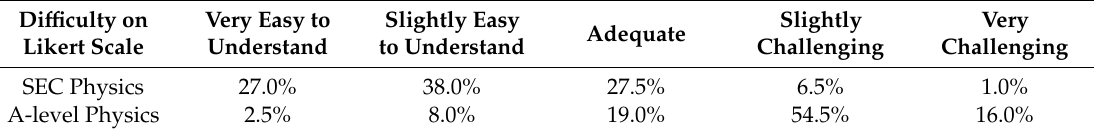
Table 1. Student perceptions of the degree of di ffi culty of SEC and AM Physics.